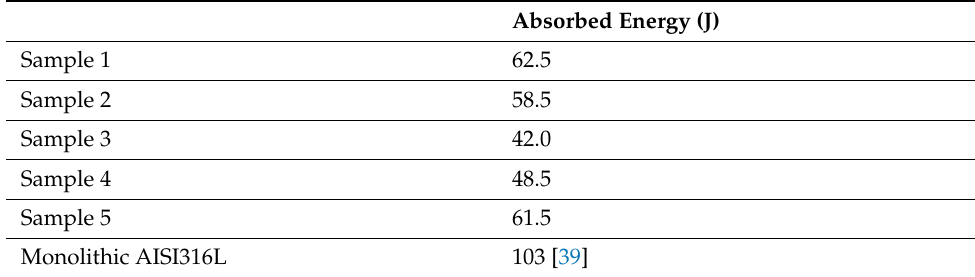
Table 4. Absorbed energy values of samples. Table 4 . Absorbed energy values of samples. Table 4 . Absorbed energy values of samples.